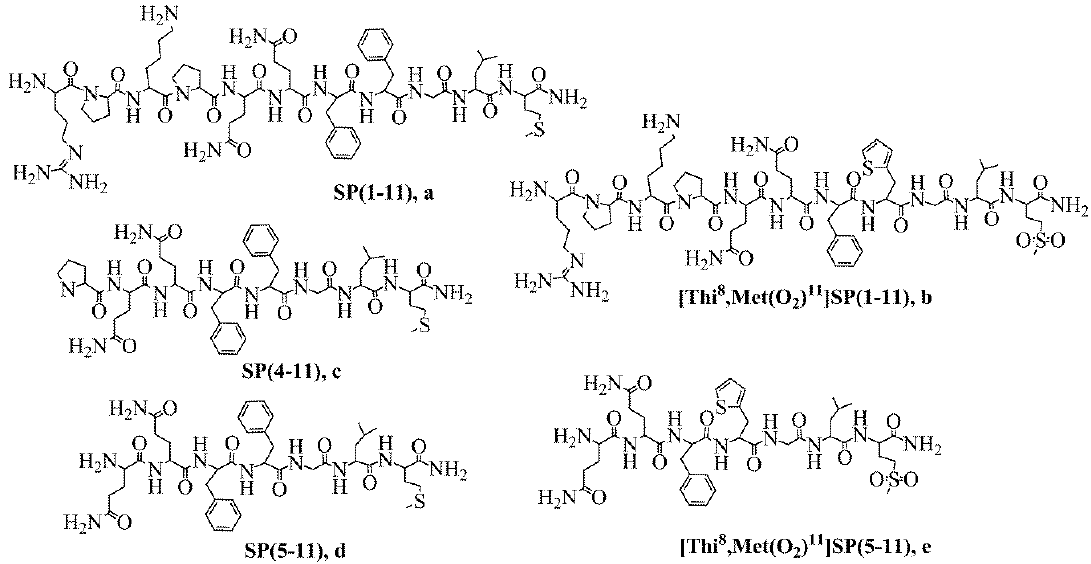
Figure 2. Structure of substance P (SP) peptide and its analogues used in this work.